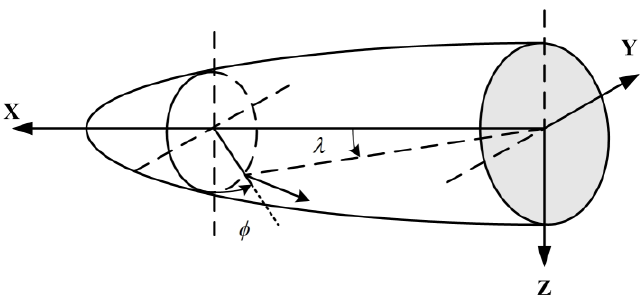
Figure 1. Conical shape applied for